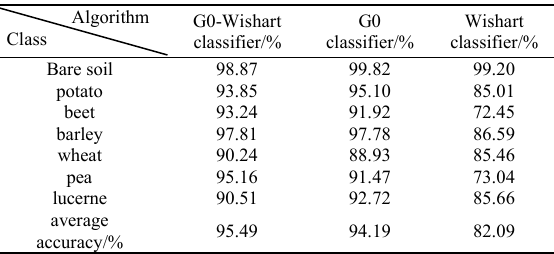
Table 1. The classification